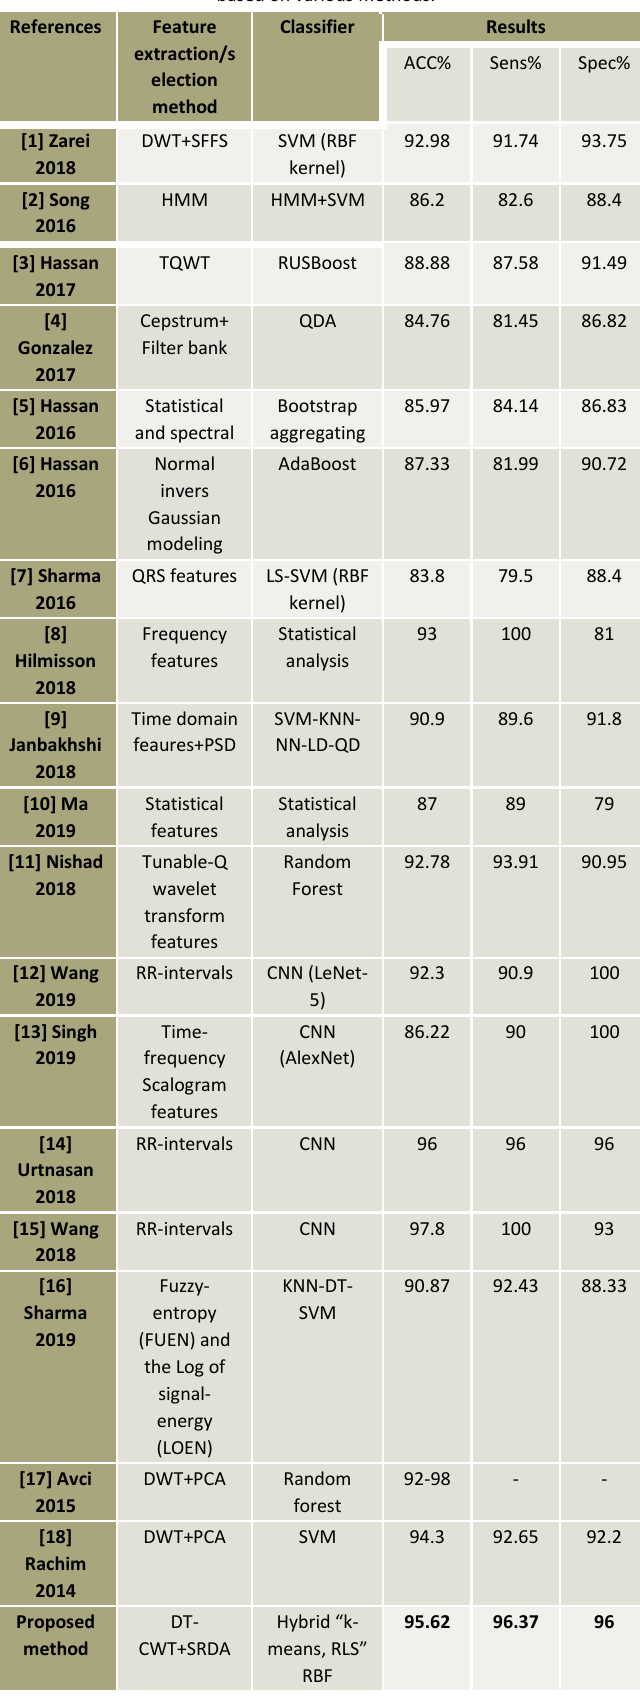
TABLE 3. The comparison of the OSA detection results based on various